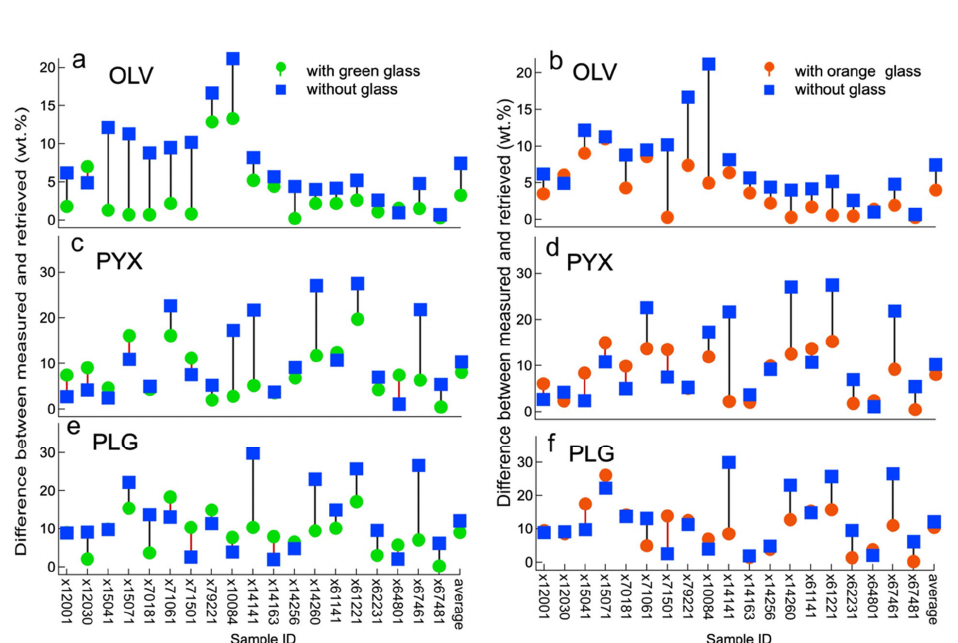
Figure 5. The absolute difference in relative abundance between the MSL retrieval of this work and the LSCC measurement (Difference = |LSCC measurement–MSL retrieval|) for OLV ( a , b ), PYX ( c , d ), and PLG ( e , f ). The blue squares indicate the weight% difference between the measurement and the retrieval with no glass considered. The green and orange circles indicate the weight% difference in retrieved and measured mineral abundances with green and orange glasses, respectively. Vertical black and red lines indicate that the retrieval results with glass considered are closer and further from the actual measurement results,